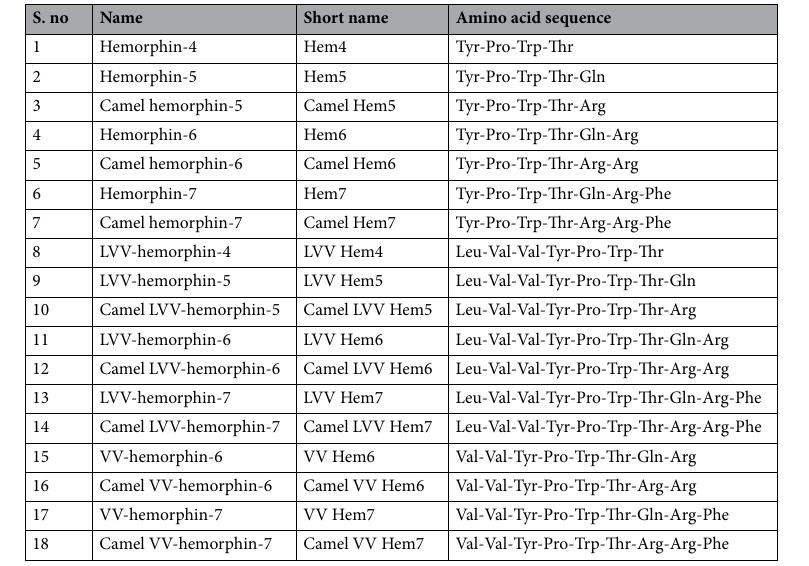
Table 2. A list of the tested hemorphin